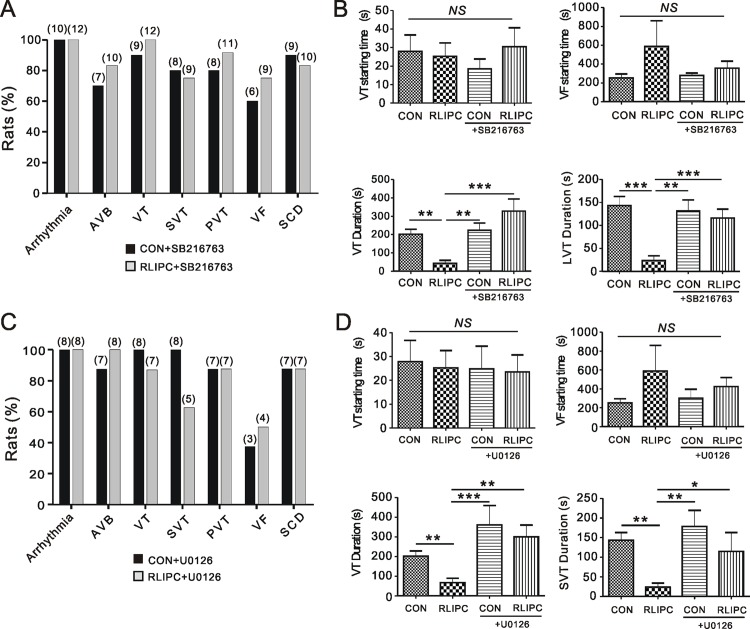
Pharmacological inhibition of ERK or GSK-3β abolishes RLIPC-induced anti-arrhythmic cardioprotection.A) The effect of inhibiting GSK-3β on post-reperfusion arrhythmia characteristics and mortality in CON (n = 10) and RLIPC (n = 12) rats upon administration of GSK-3β inhibitor SB216763 prior to coronary ligation. Numbers of animals per category are indicated in parentheses. CON, control; RLIPC, remote liver ischemia preconditioning. AVB, AV block; VT, ventricular tachycardia; SVT, sustained VT (>1min VT); PVT, polymorphic VT; VF, ventricular fibrillation; SCD: sudden cardiac death. B) Mean values for onset time of first VT (upper left)/VF (upper right) episode after reperfusion and durations of VT (lower left), the longest episode of VT duration (LVT, lower right) for control (n = 10) and RLIPC (n = 12) rats upon GSK-3β inhibitor SB216763 application. Values for control and RLIPC rats are repeated from Fig 3 for comparison. NS, no significant difference, **P<0.01, ***P<0.001 compared withRLIPC (by One-way ANOVA). C) The effect of administering ERK inhibitor U0126 to CON (n = 8) and RLIPC (n = 8) rats on post-reperfusion arrhythmia characteristics and mortality. Values in parentheses indicate the numbers of rats per category. D) Mean values for onset time of first VT (upper left)/VF (upper right) episode after reperfusion and durations of VT (lower left), the longest episode of VT duration (LVT, lower right) for control (n = 8) and RLIPC (n = 8) rats upon ERK inhibitor U0126 application. Values for control and RLIPC rats are repeated from Fig 3 for comparison. NS, no significant difference, *P<0.05, **P<0.01, ***P<0.001 compared withRLIPC (by One-way ANOVA).